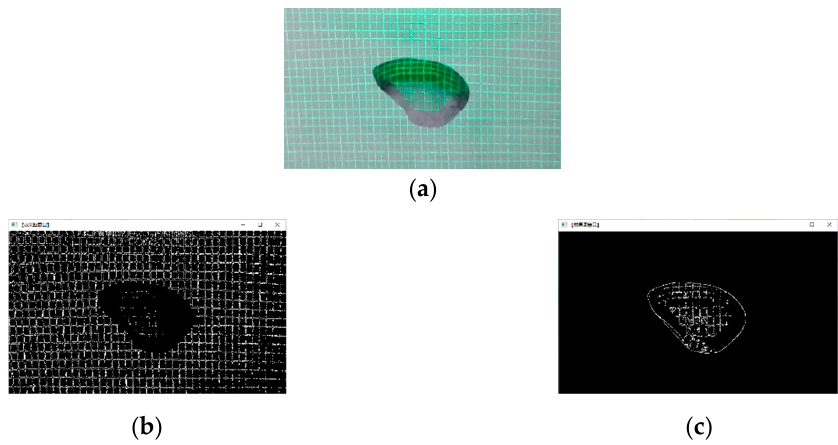
Figure 26. The irregular pothole that was similar in color to the background. ( a ) The irregular pothole ( b ) the contour of the ground; ( c ) the contour of the irregular pothole. Table 2. The results of recognizing the contours of different types of obstacles in parking spaces. Model Types Regular Irregular Similar to the Ground Color 63 = 98.4% Vehicle 64